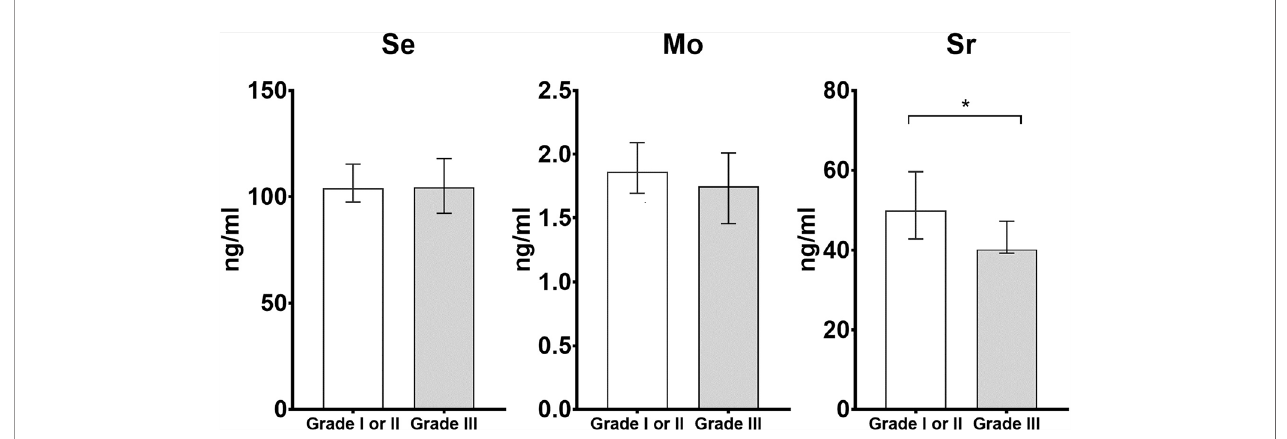
FIGURE 1 | Histograms of differential trace elements (i.e., Se, Mo, and Sr) for the comparison between cases with low histologic grade (i.e., Grade I or II) and high histologic grade (i.e., Grade III). The x-axis is the histologic grade, and the y-axis is the concentration of Se, Mo and Sr (ng/ml). * statistically signi fi cant with p < 0.05 in the comparison between cases with low and high histologic